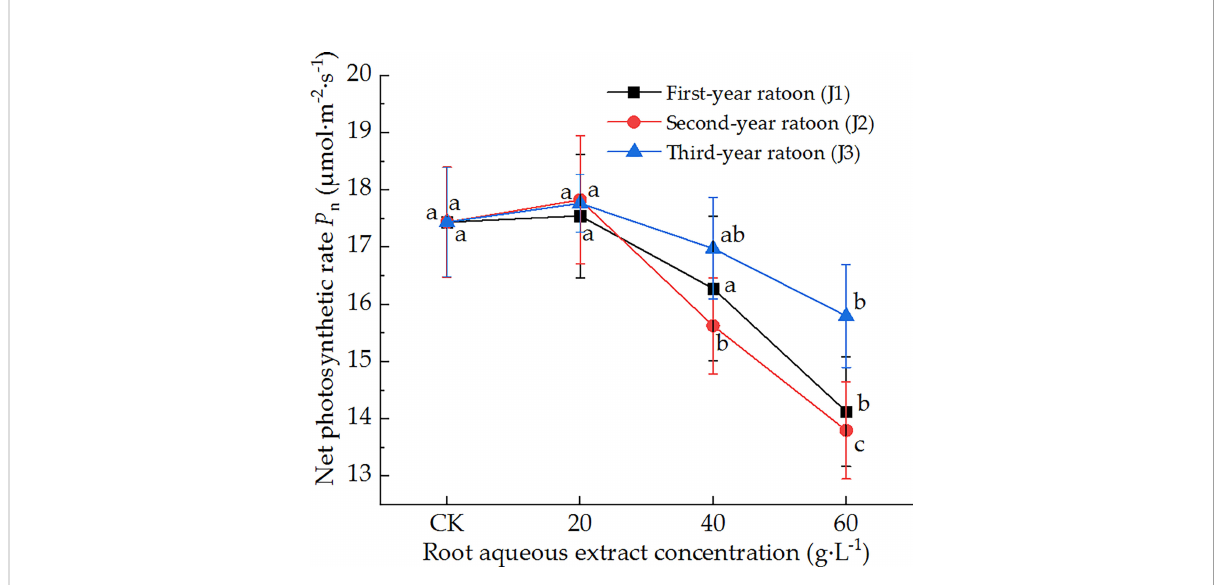
FIGURE 2 Response of P n in sugarcane seedlings to different root aqueous extracts. Different lowercase letters represent signi fi cant differences at the 5% level between different concentrations of root aqueous extract with the same ratoon